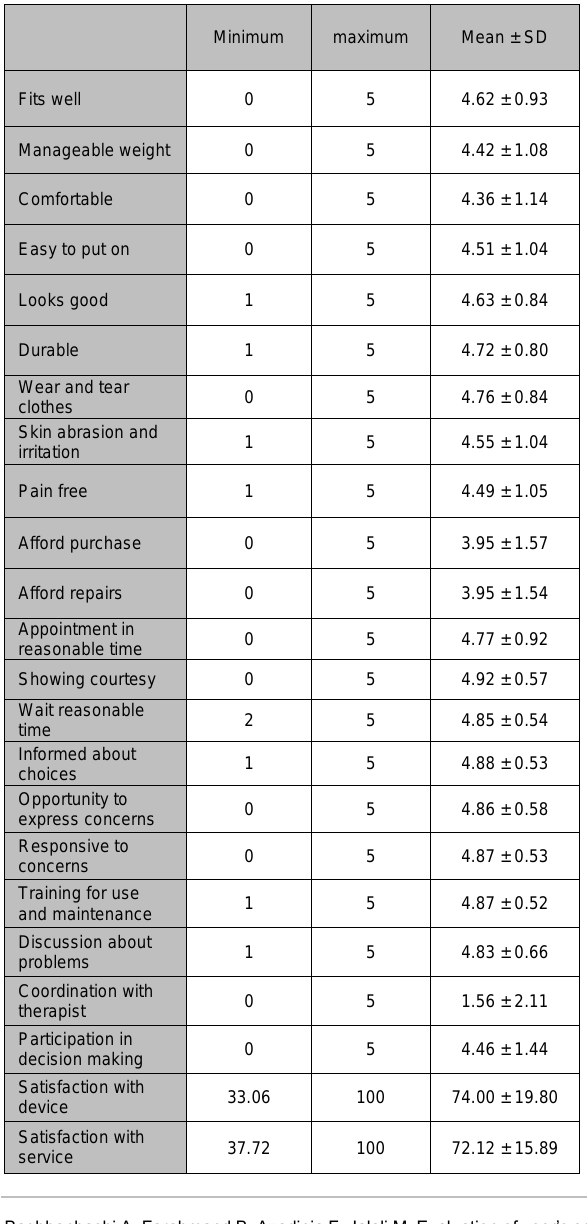
Table 2: Mean, standard deviation and range of items and (device and service) total scores of the OPUS.